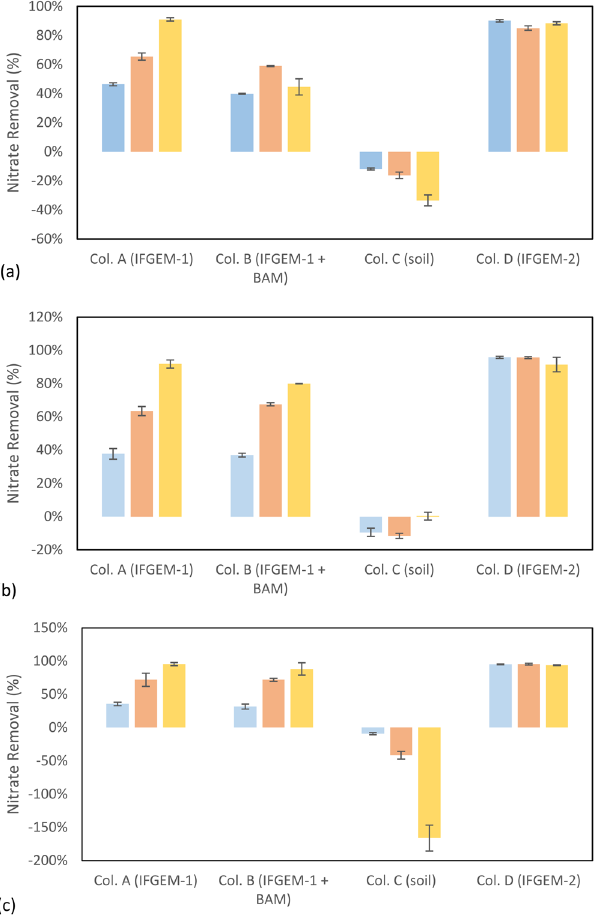
Figure 5. Outcome of the column study:cumulative nitrate removal at each section through columns when inlet nitrate concentration = ( a) 0.6 mg/L, ( b ) 1.2 mg/L, and ( c ) 1.8